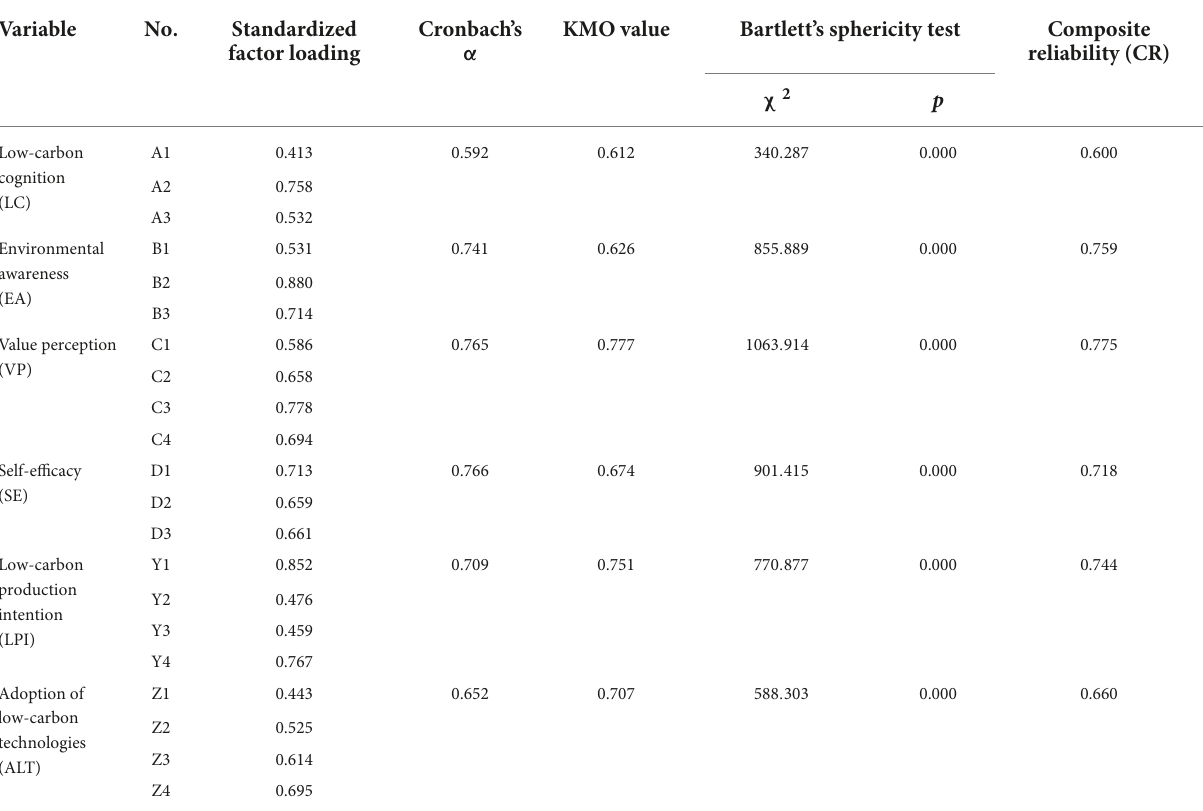
TABLE 4 Results of the variable reliability and validity